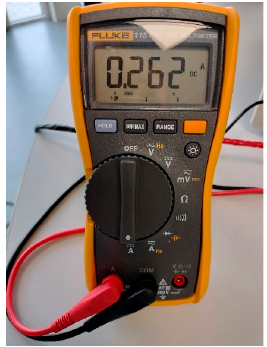
Figure 34. Fluke 115 Digital Multimeter.